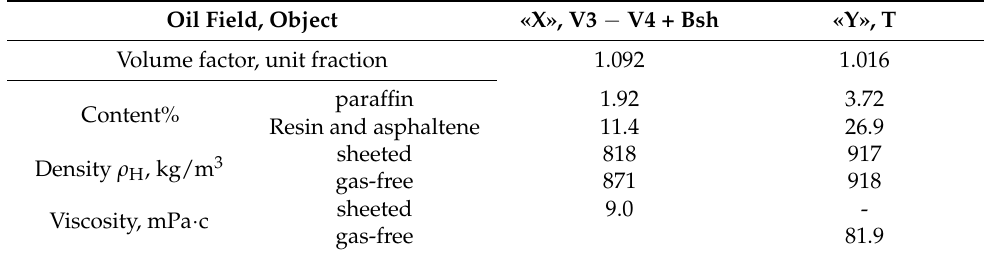
Table 1. Physical and chemical characteristics of the oils.